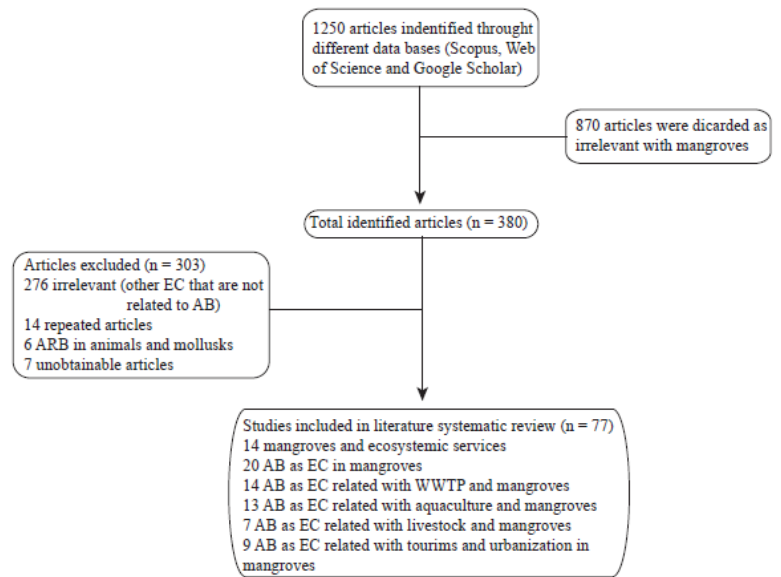
Figure 1. Flow diagram of identification and selection process included in systematic review.